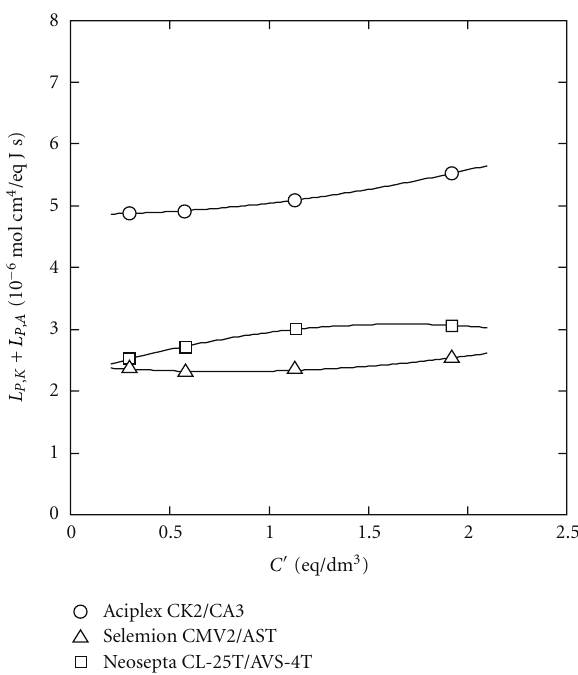
Figure 12: Relationship between salt concentration in a feeding solution and hydraulic